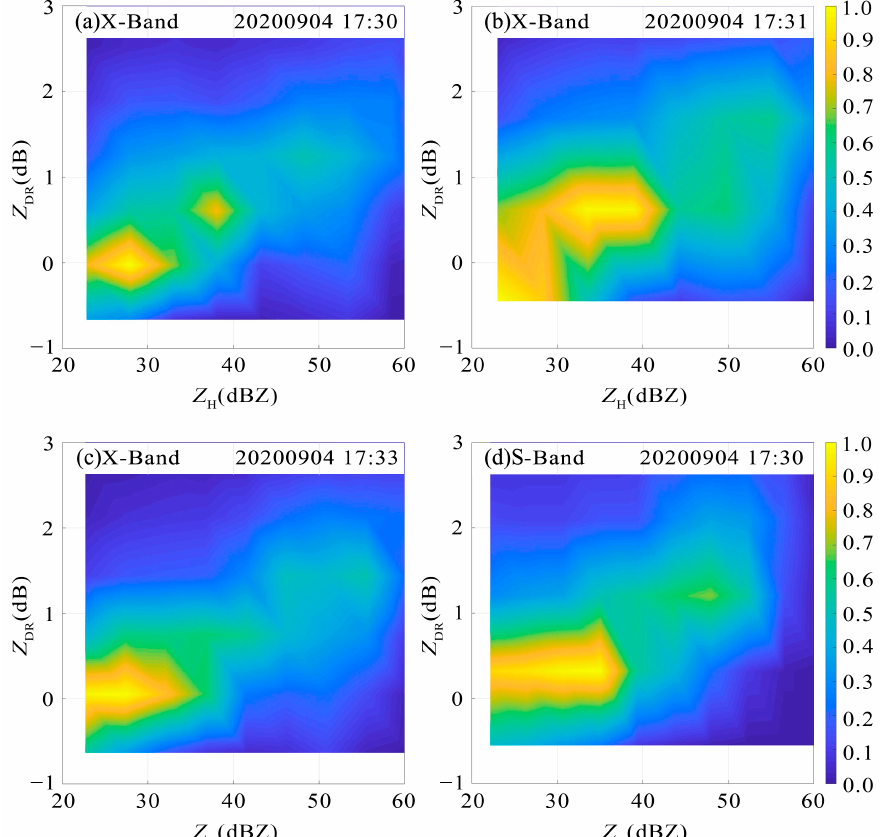
Figure 12. The normalized density of Z H - Z DR in the local heavy precipitation rainband observed by the Panyu X-band PAR at ( a ) 17:30, ( b ) 17:31, ( c ) 17:33, and ( d ) the S-band radar at 17:30 on 4 Sep- tember 2020.